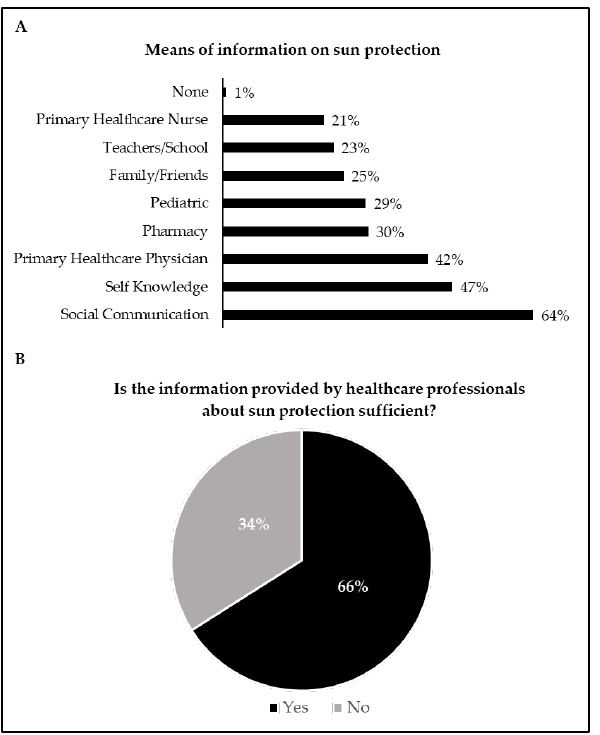
Figure 3. Means of information on sun protection ( A ); information provided by healthcare professionals ( B ). In Figure 3A, the sum of the proportions exceeds 100% because multiple-choice answers were allowed.